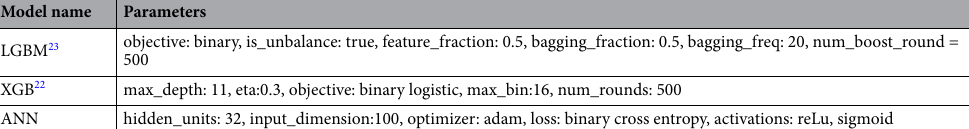
Table 5. Classifier model parameter